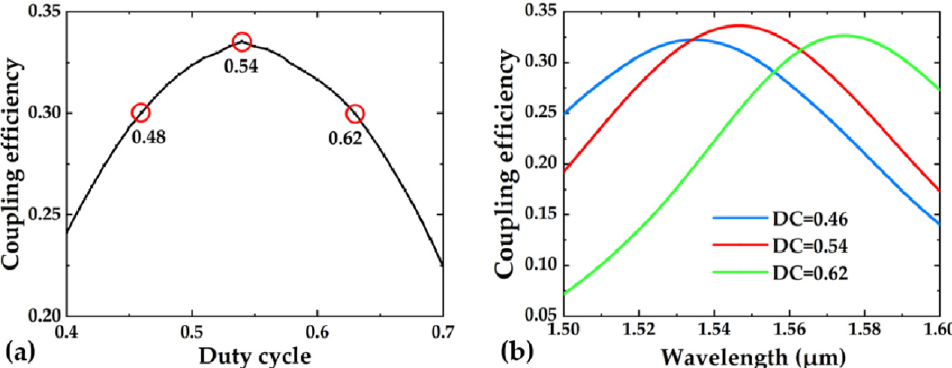
Figure 4. ( a ) Coupling efficiency as a function of the duty cycle. ( b ) Coupling efficiency as a function of the wavelength at different duty cycles.